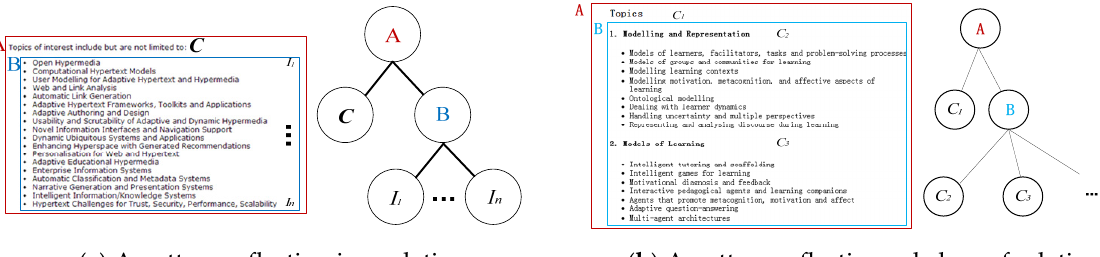
Figure 3. Patterns reflecting is-a relation and subclass-of relation.